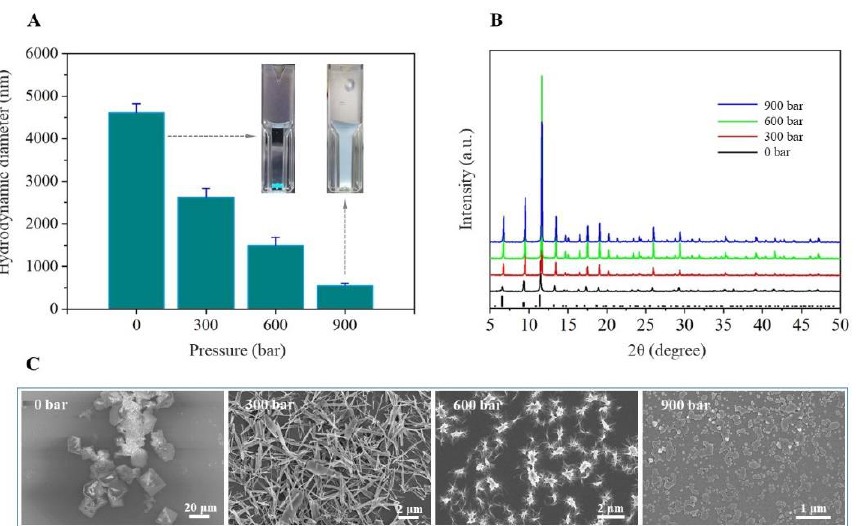
Figure 2. High-pressure homogenization treatment of as-prepared HKUST-1. ( A ) Pressure-dependent hydrodynamic diameter evolution of HKUST-1 particles. The inserted picture shows the solution state after mechanical treatment at the corresponding pressure. X-ray diffraction patterns ( B ) and scan electron microscopy images ( C ) of the HKUST-1 treated under different pressure.